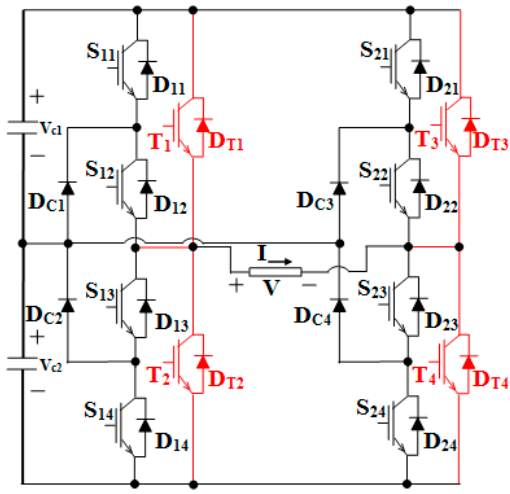
Figure 2. Proposed fault-tolerant topology.